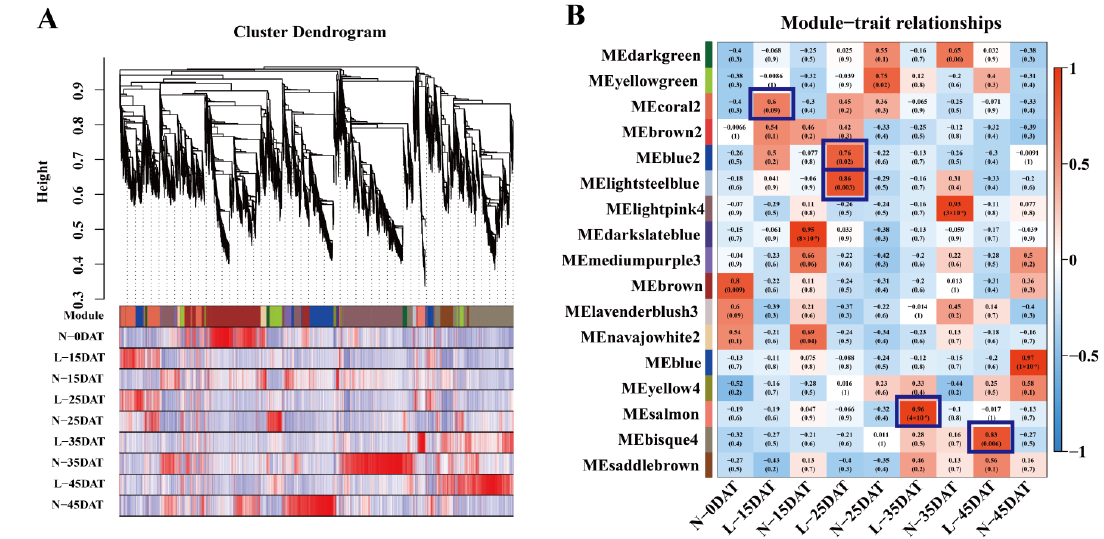
Figure 2. WGCNA analysis of ‘XBJ’ at different low temperatures. ( A ) Hierarchical cluster trees showed the co-expression modules identified by WGCNA. ( B ) Co-expression modules by WGCNA. Relationships between modules (left) and traits (bottom). Red and blue represent positive and negative correlations, respectively, with coefficient values and p -values. The module – trait relationships (MTRs) were different for each low-temperature treatment. These modules contained positively and negatively related genes, and their